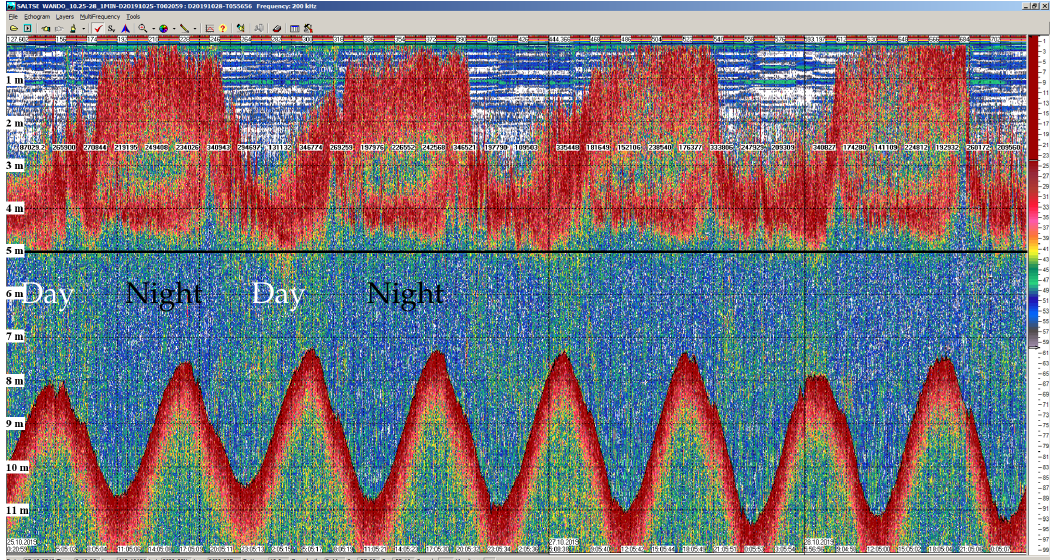
Figure 3. Echogram for the duration of 92 h performed in